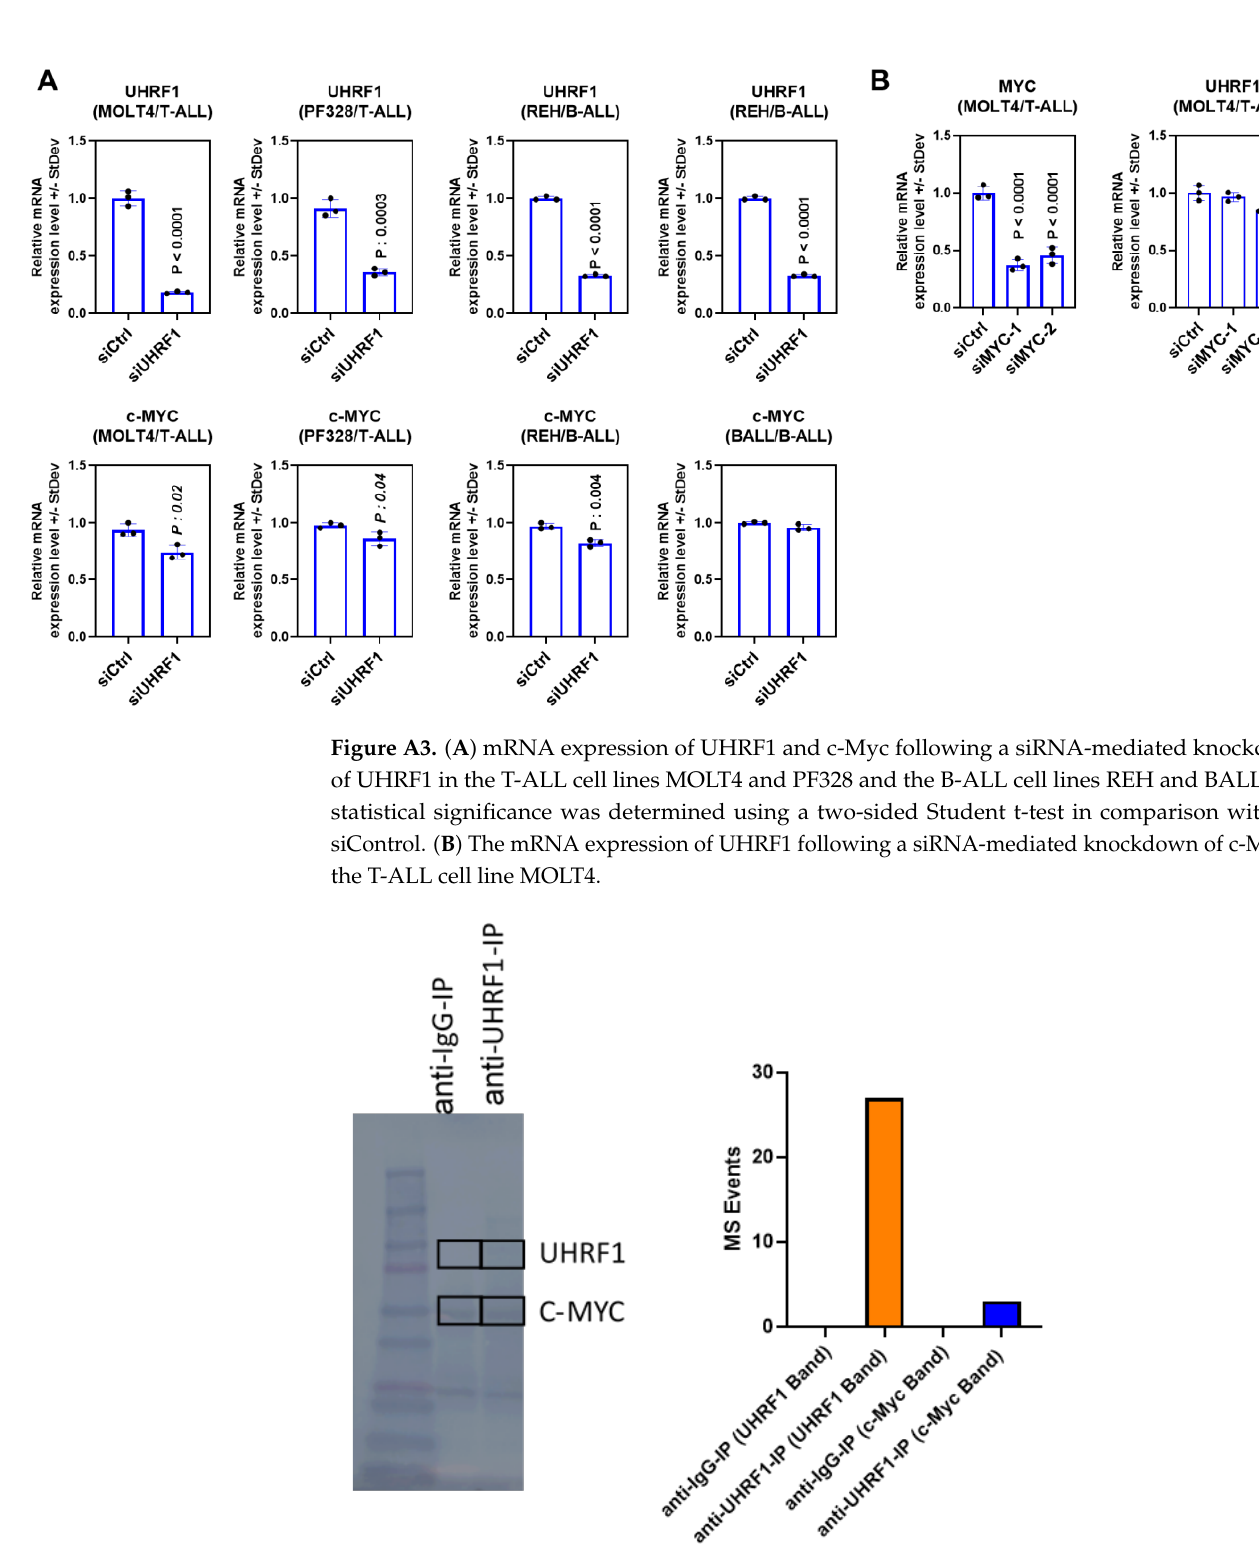
Figure A4. Co-immunoprecipitation analysis of UHRF1 and c-MYC from REH cells. The uncropped blots are shown in Figure S1.